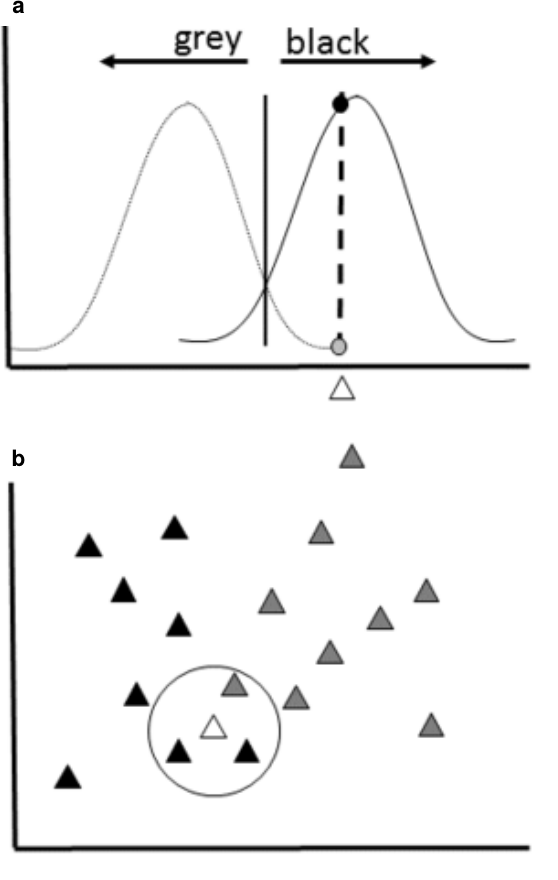
Figure 9. Bayesian Classi fi er Schematic : This diagram shows a simpli fi ed schematic of a Bayesian classi fi er working to assign a new datum (white triangle) to one of two classes (grey and